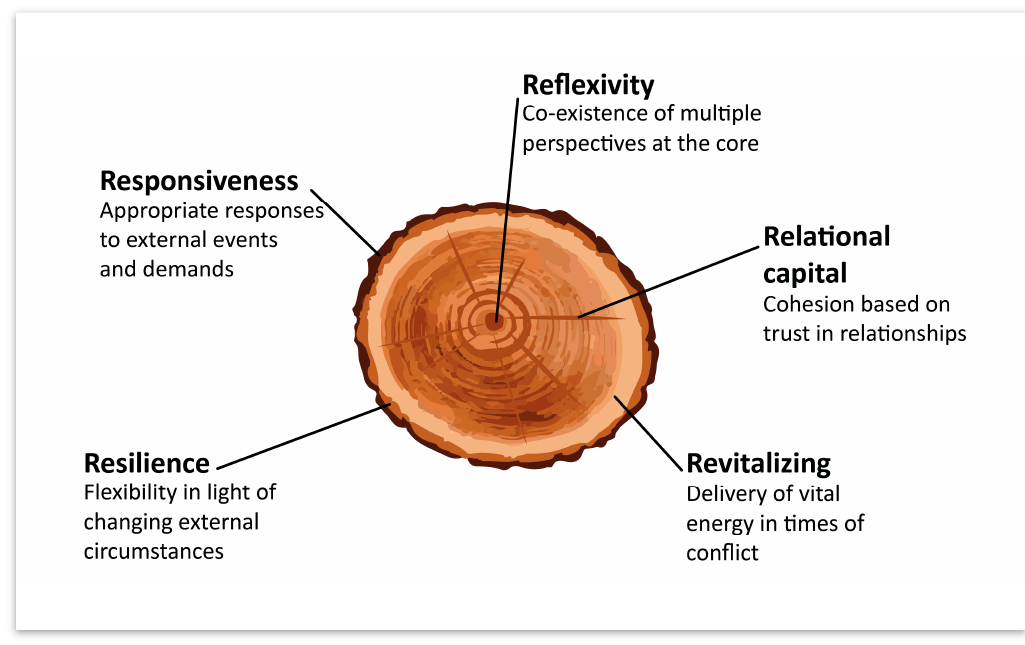
Figure 1. The ‘five R s’: Guiding principles for collaborative stakeholder networks.